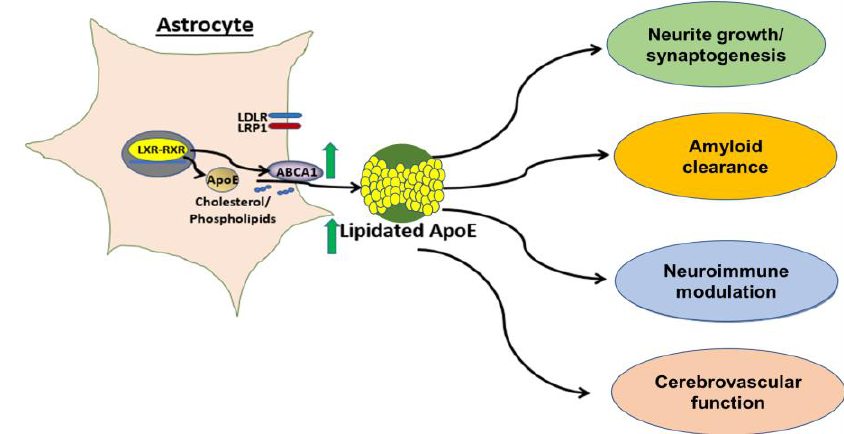
Figure 1. Increasing lipidation of the astrocytic pool of apoE. Astrocytes are the primary producer of apoE in the brain. Common mechanisms of apoE and abca1 expression are driven by nuclear hormone receptor (such as LXR and RXR) activation. Abca1 is critical for lipidation of apoE and increasing expression of abca1 leads to increased lipidation of all apoE isoforms (indicated by green arrows). We hypothesize that increasing apoE lipidation will be beneficial for several AD-relevant endpoints.